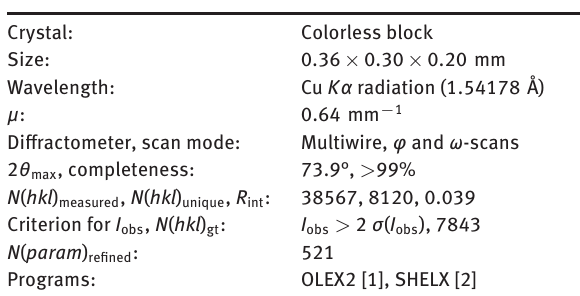
Table 1: Data collection and